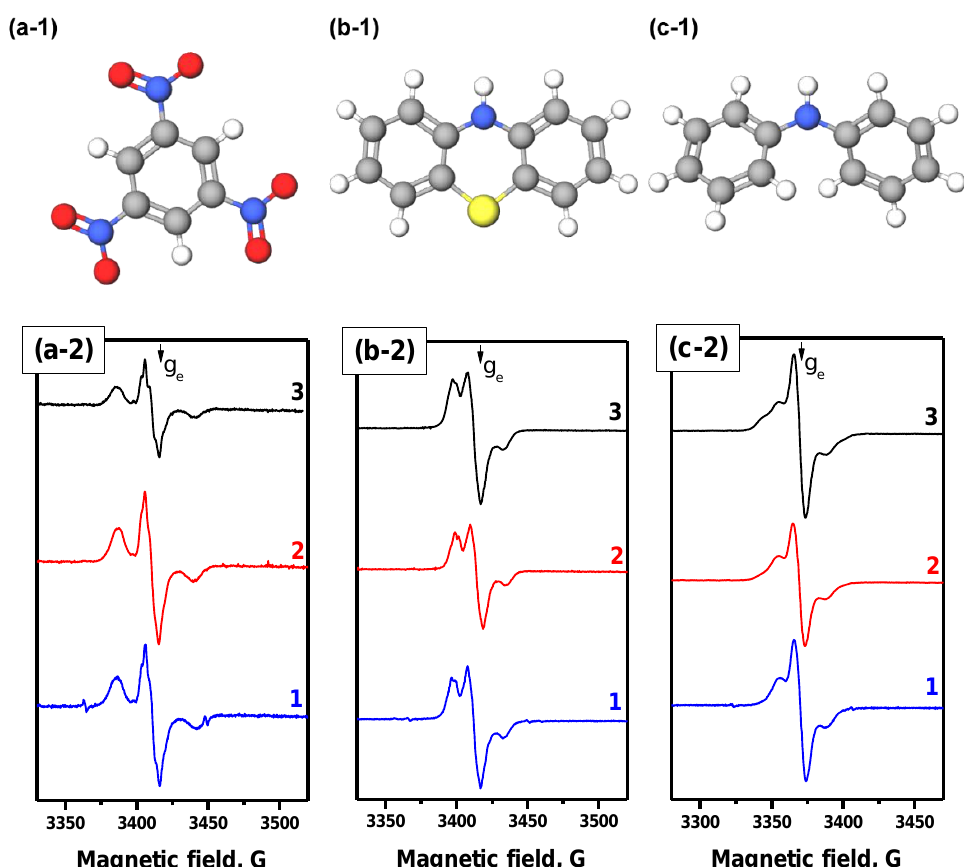
Figure 3. Spin probes and EPR spectra observed after their adsorption over C12A7 (1); 5%V/C12A7 (2); and 10%V/C12A7 (3) samples activated at 500 °C: 1,3,5-trinitrobenzene ( a ); phenothiazine ( b ); and diphenylamine ( c ). Designation of the atoms: carbon (grey); hydrogen (white); nitrogen (blue); oxygen (red); sulfur (yellow).